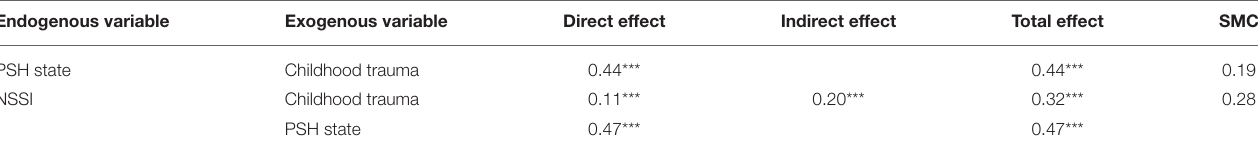
TABLE 5 | Direct, indirect, and total effects of the final structural